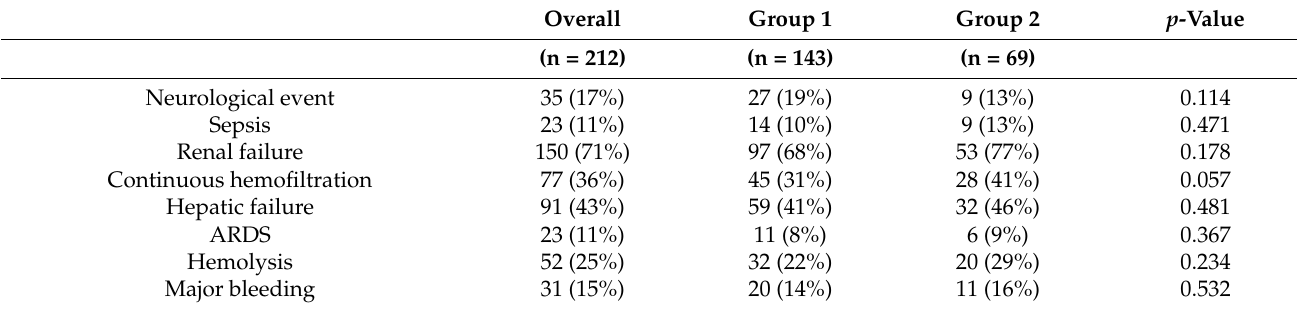
Table 3. Major complications during ECLS.